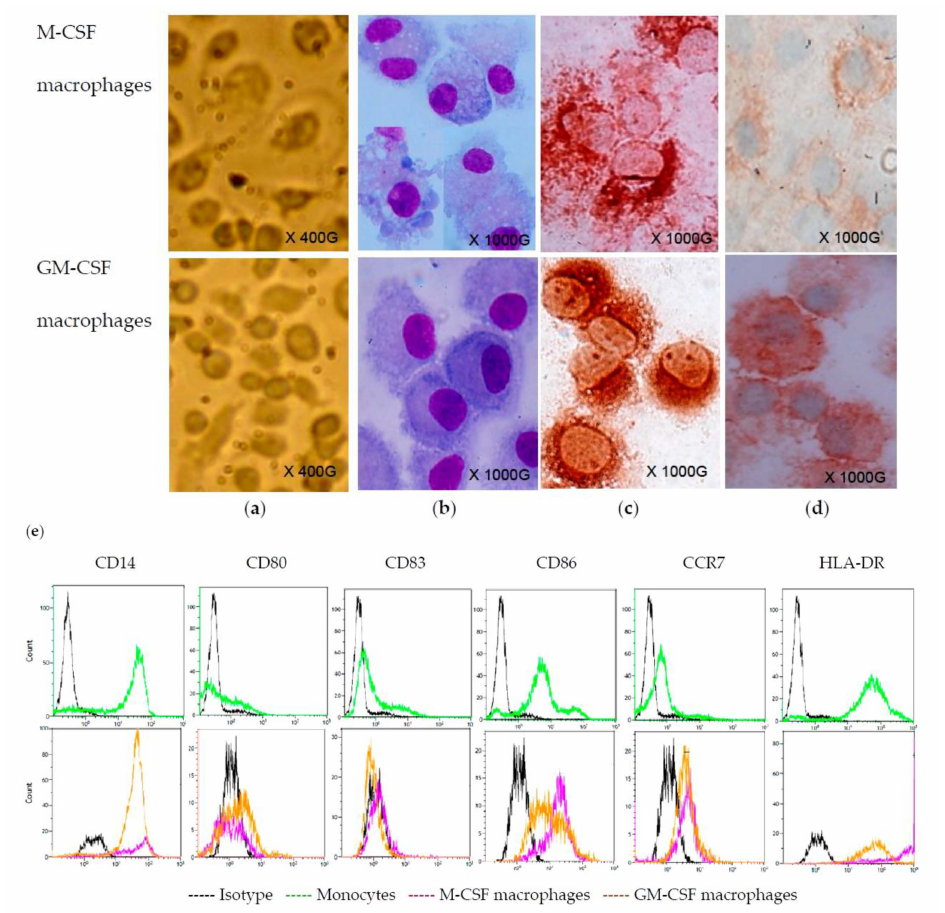
Figure 1. Monocyte-derived macrophages. Monocytes were maintained in serum-free culture medium containing M-CSF or GM-CSF for 7 days. Then cells were directly observed in the culture plate under an inverted microscope (initial magnification X400) ( a ). Cells were cytocentrifuged on slides and stained with MGG ( b ) or labeled with anti-CD68 ( c ) and anti-CD163 ( d ) antibodies by immunocytochemistry (initial magnification X1000). Parental monocytes and derived macrophages were collected and analyzed by flow cytometre ( e ). These observations are representative of three independent